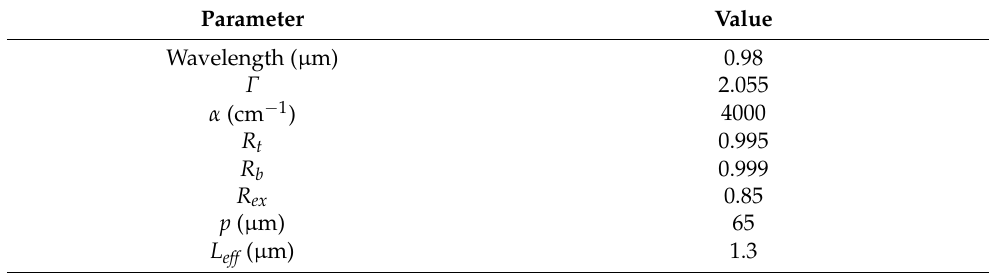
Table 1. Parameters of the